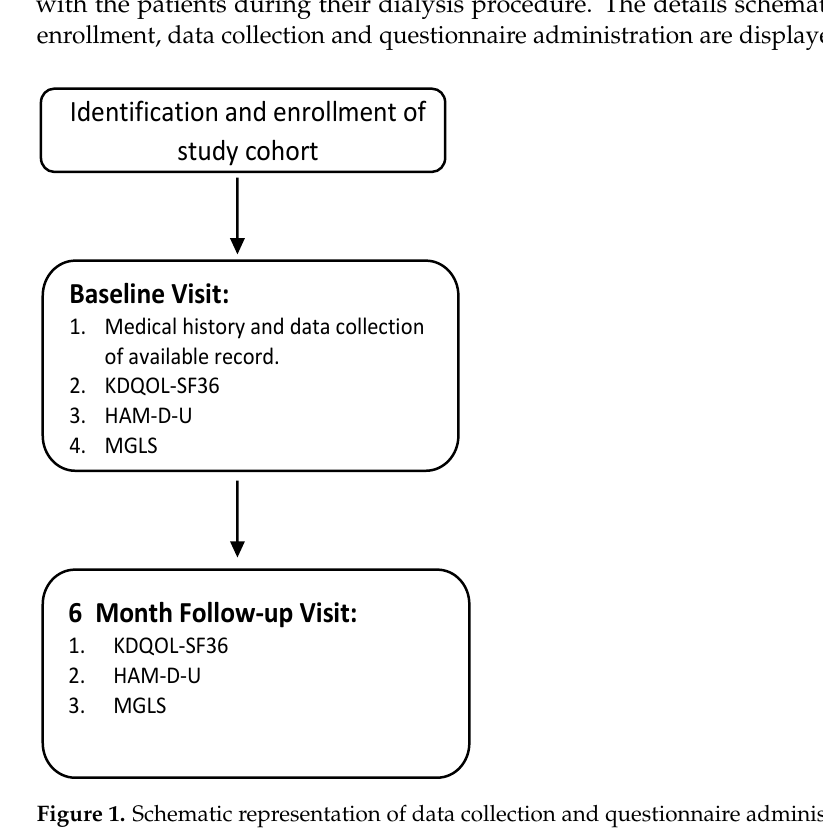
Figure 1. Schematic representation of data collection and questionnaire administration.